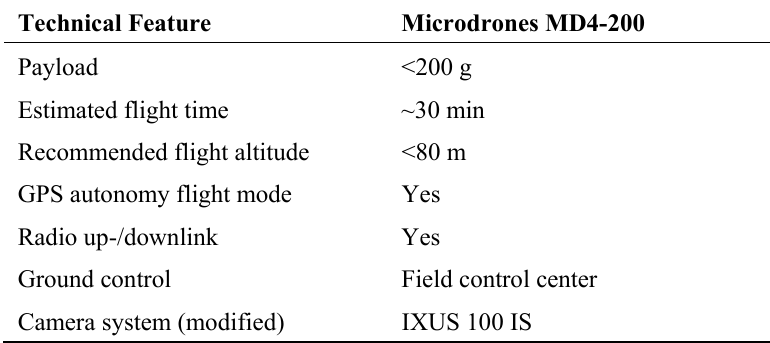
Figure 1. The commercial “ready-to-use” Microdrones MD 4-200. Payload includes IMU, GPS receiver, downward pointing CIR-modified digital Canon IXUS 100 camera, radio downlink and microprocessor controlled flight control units. Table 1. Key-features of the used quadrocopter